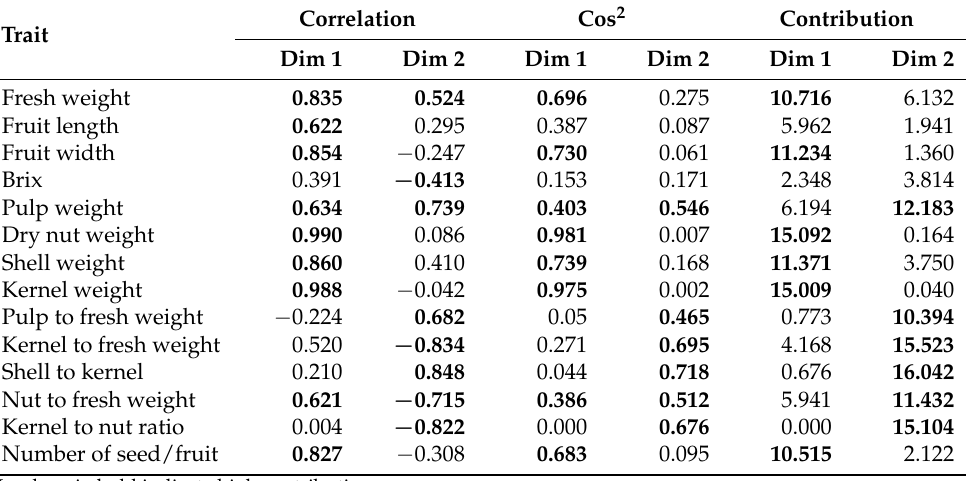
Table 4. Correlation, quality of representation (Cos2) and contribution of each trait with principal components.